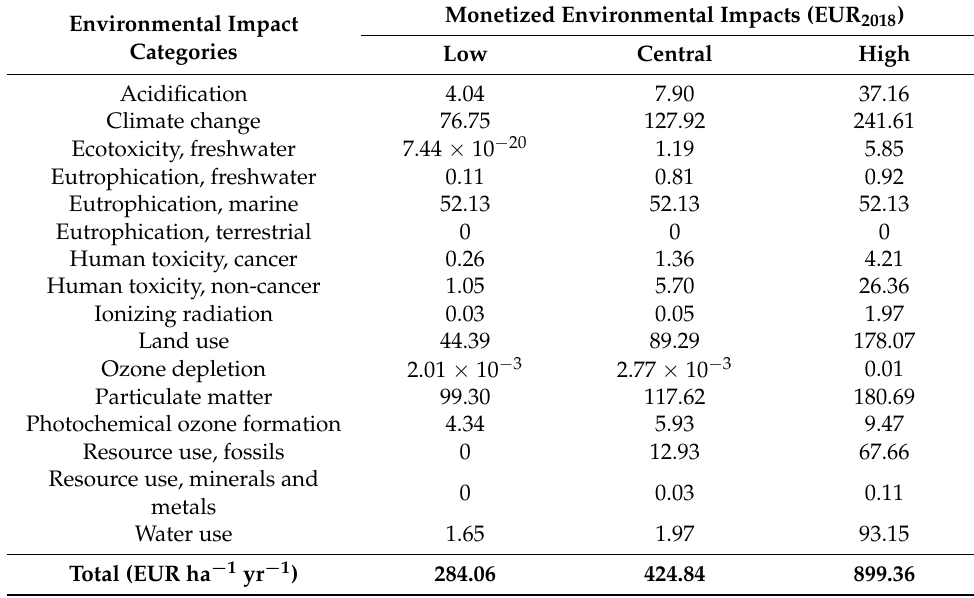
Table 6. Monetized environmental impact of miscanthus cultivation applying the monetization factors by Trinomics (2020) [22].